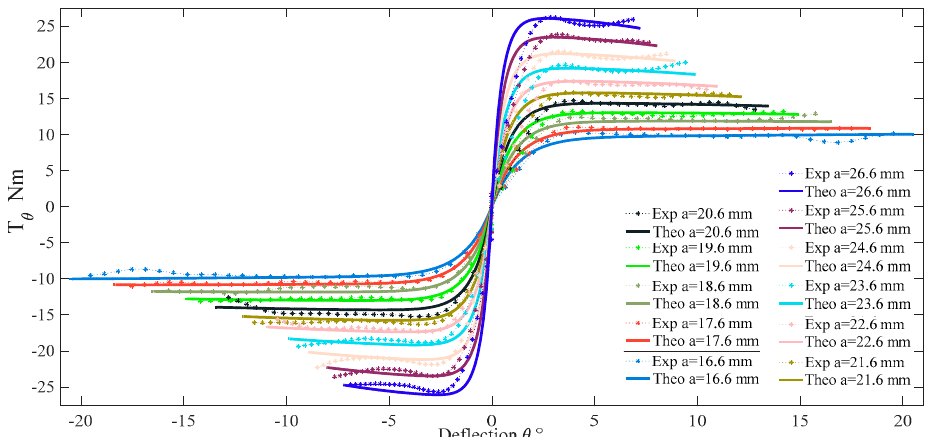
Figure 15. V2SOM characteristics: theoretical (in solid lines) and experimental (in dotted lines) with the 11 different SAB settings.